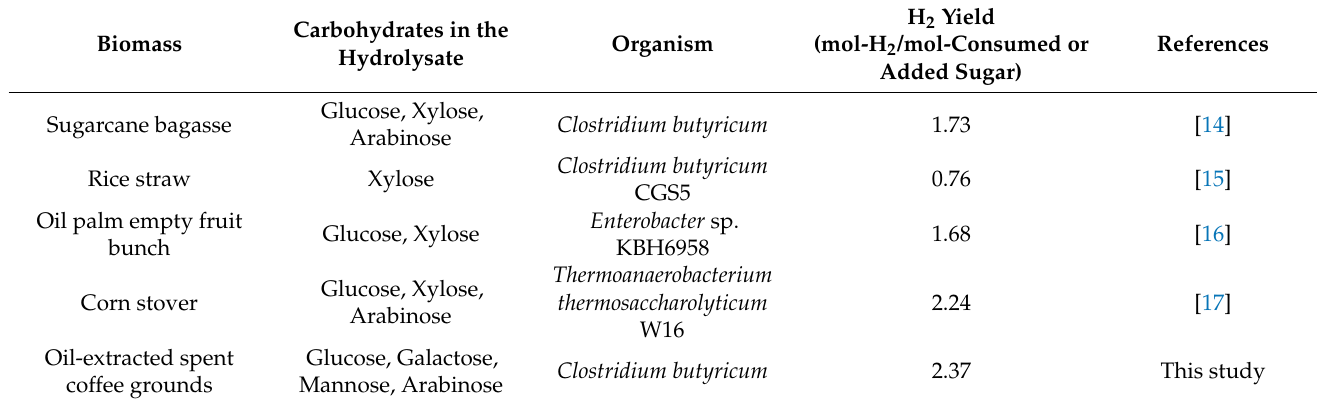
Table 3. Comparisons of hydrogen productivities using various